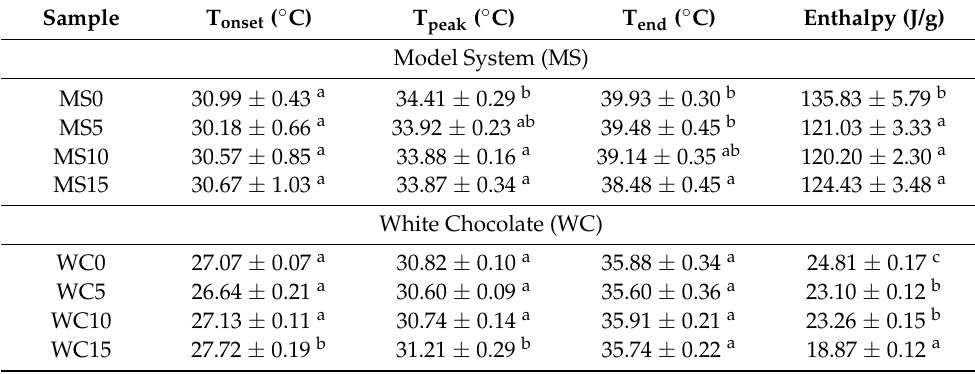
Values represent the mean value of 3 measurements. Values followed by the same letter within the same column (within the values for model system or white chocolate) are not significantly different ( p > 0.05) according to Duncan’s